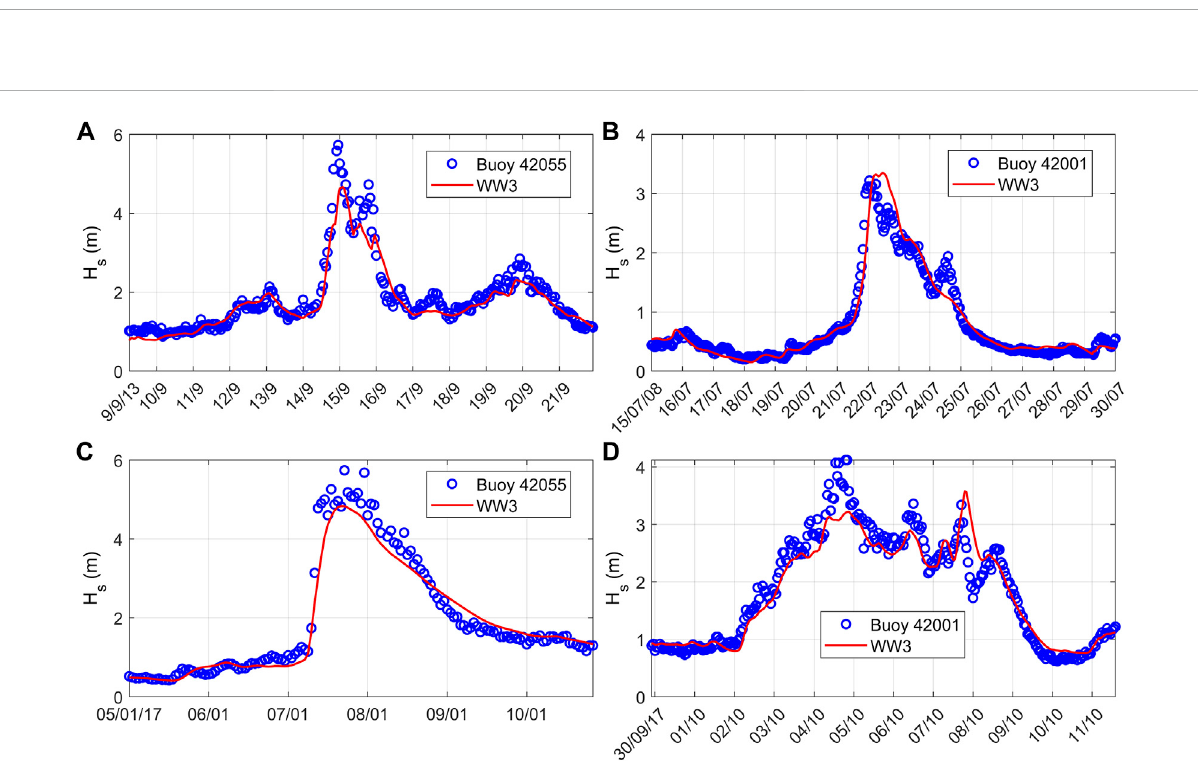
FIGURE 5 Comparison of the modelled signi fi cant wave heights and measured time series for selected extreme events: (A) Hurricane Ingrid (September 2013); (B) Hurricane Dolly (July 2008); (C) Cold front, January 2017; and (D) Cold front, October